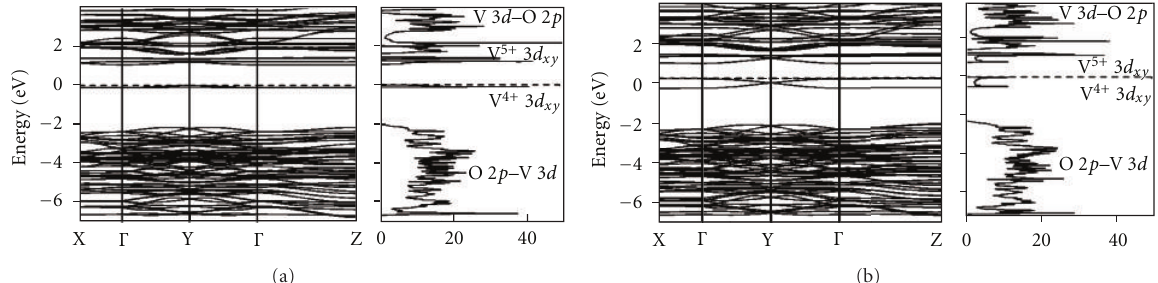
Figure 31: LDA+ U band structure and the total DOS for two di ff erent kinds of magnetic ordering of V 4+ moments within the in-line CO model: (a) AF intra-chain ordering; (b) F intra-chain and AF inter-chain ordering [245].